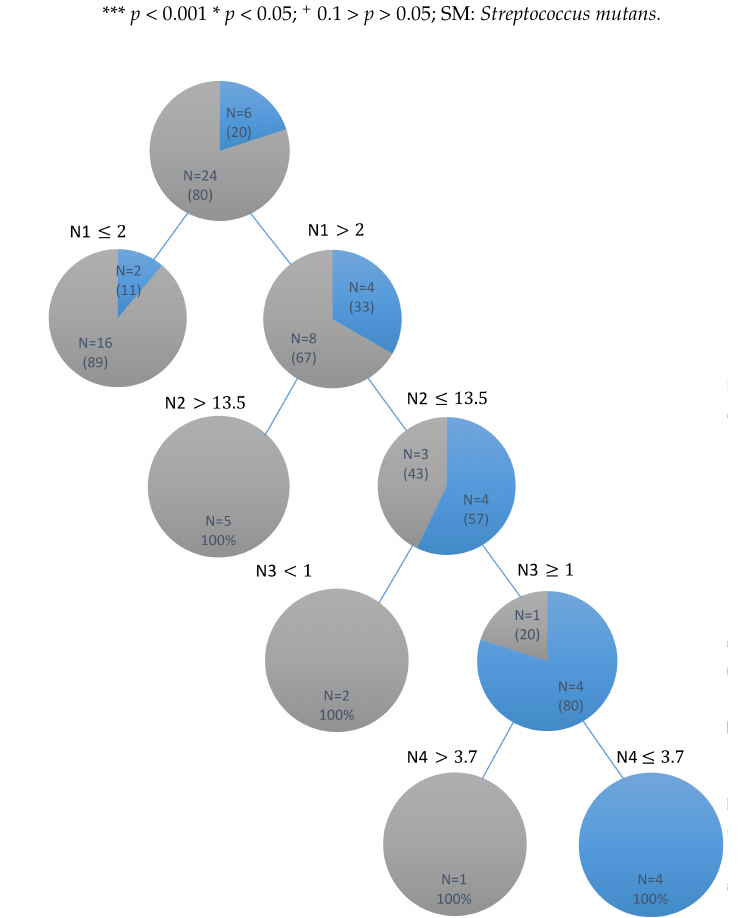
Figure 1. DT (decision tree) for the dental caries outcome in children identified by their parents’ periodontal clinical and microbiological outcomes. children with dmft ≤ 3; children